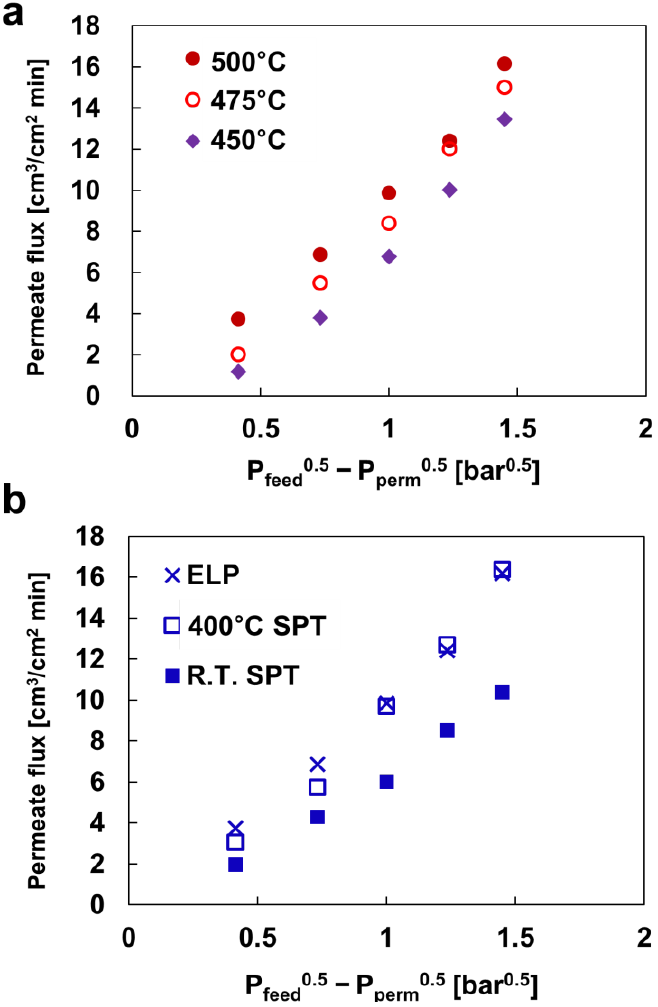
Figure 2. H 2 permeability of ( a ) electroless-plated (ELP) Pd/Ta membrane and ( b ) the membranes prepared by different methods at 500 °C and 5 bar.